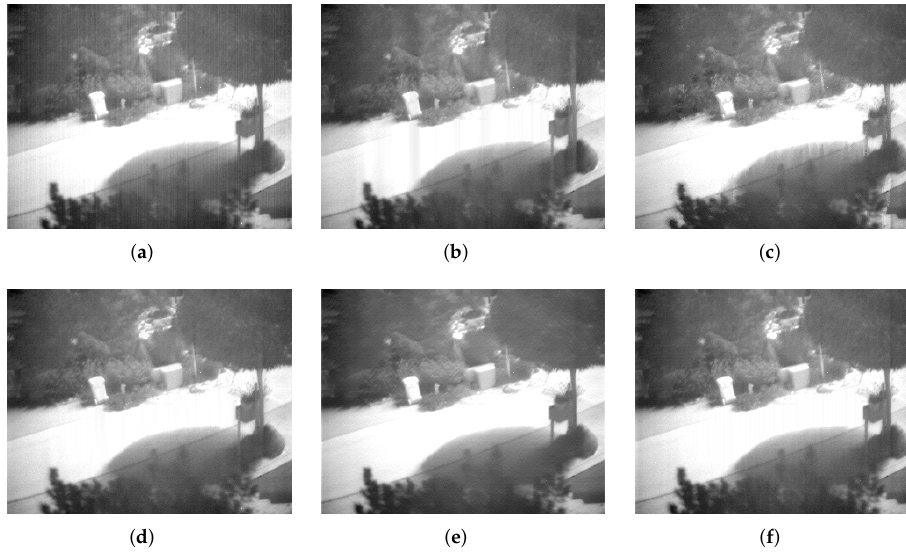
Figure 7. Stripe nonuniformity correction results for Street. ( a ) Raw; ( b ) WTSF; ( c ) MIRE; ( d ) GIF; ( e ) CNN; ( f ) Ours.